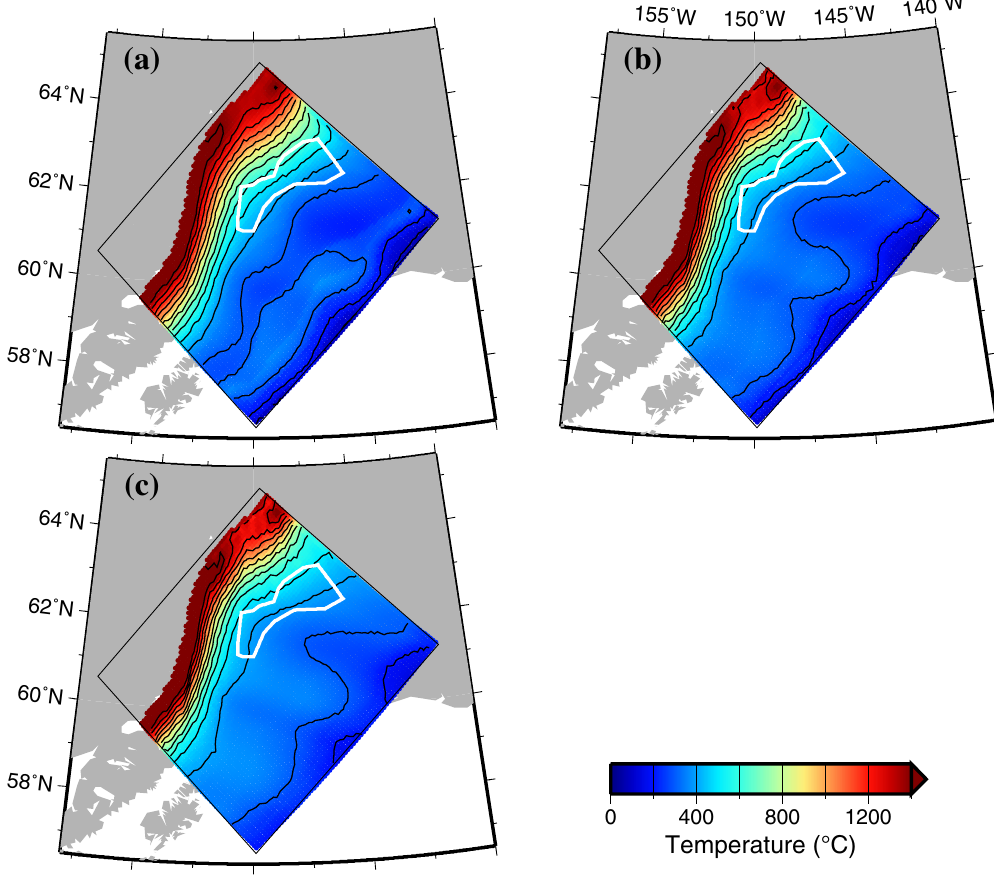
Figure 2. Temperature distribution in the slab at present (0 Ma). The thin black box represents the model region. The temperature distribution is plotted only in the region where the depth of the slab surface is shallower than the bottom of the model (200 km), with a contour interval of 100 °C. The white line indicates the area where tectonic tremors occur, as shown in Fig. 1. ( a ) The slab surface (0 km). ( b ) 6 km depth from the slab surface. ( c ) 10 km depth from the slab surface. The map was created by using the Generic Mapping Tools (GMT) 25 (version: GMT 4.5.7, URL link: https:// www. gener ic- mappi ng- tools. org/ downl